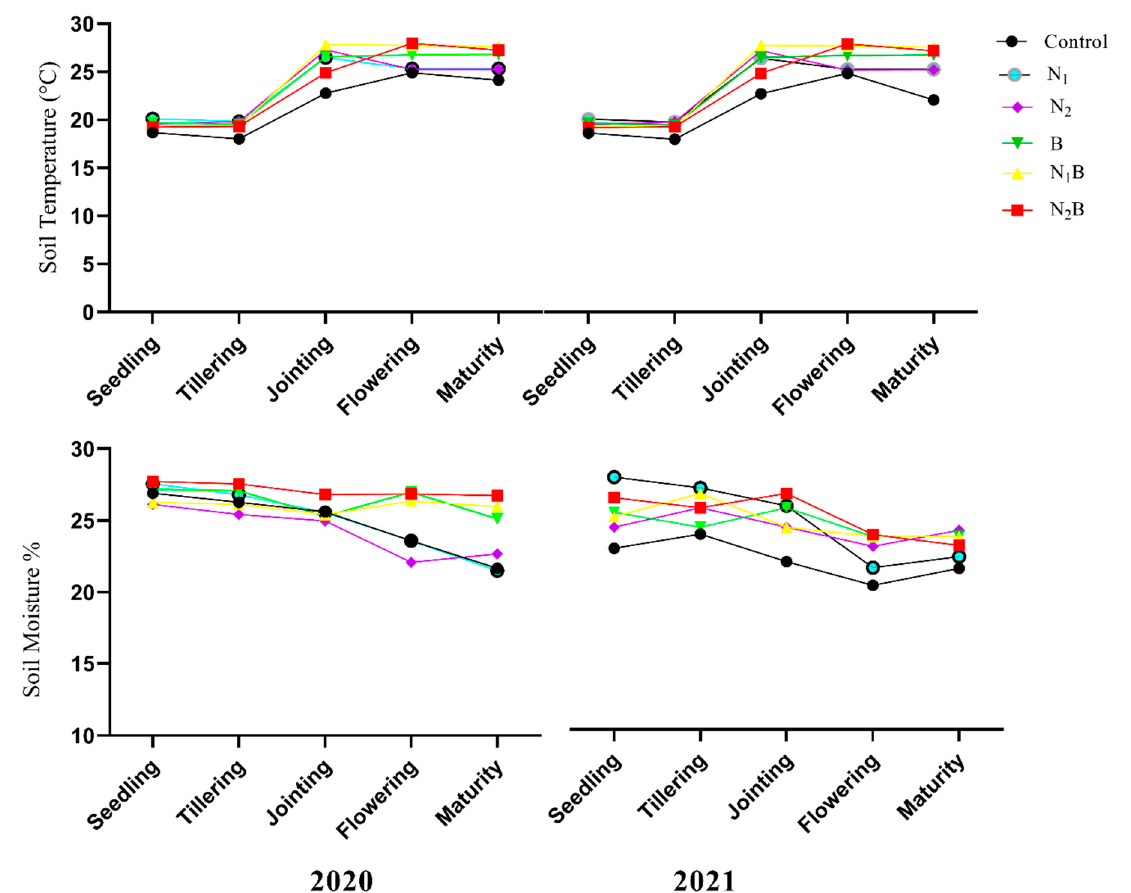
Figure 5. Changes in soil moisture content (%) and soil temperature (°C) in different growth stages of spring barley (2020) and pea crops